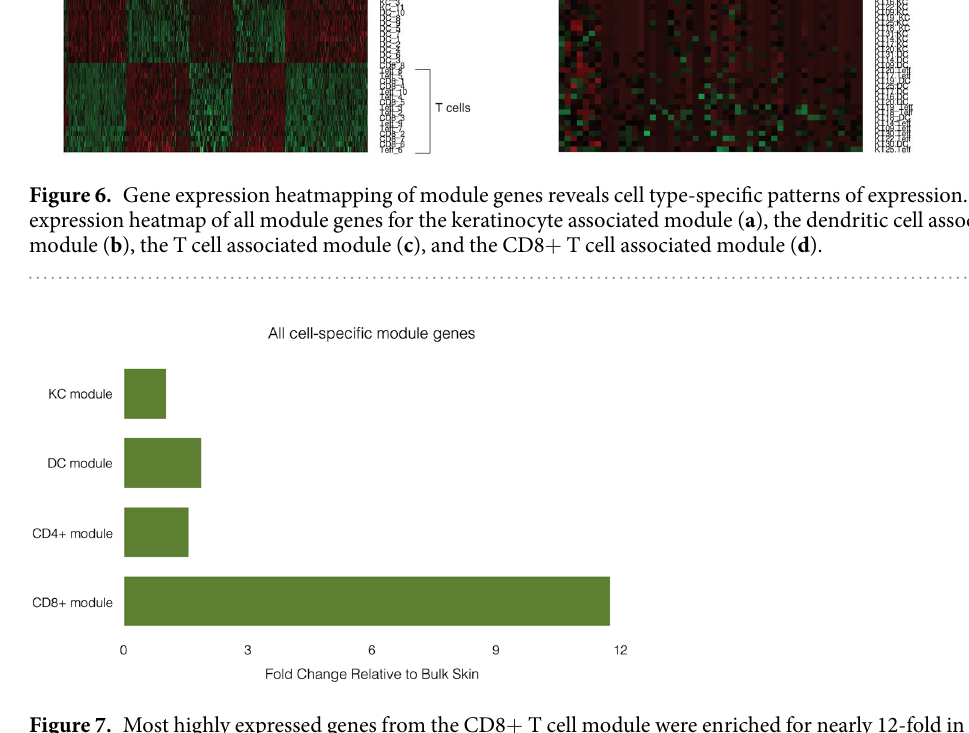
Figure 7. Most highly expressed genes from the CD8 + T cell module were enriched for nearly 12-fold in CD8 + T cell populations relative to bulk samples. The summed expression of the top 50 most expressed genes from each module was averaged across all samples in each cell population and from the bulk samples. Fold change relative to bulk skin is defined as the ratio of the average summed expression across samples in each population to the average summed expression in the bulk